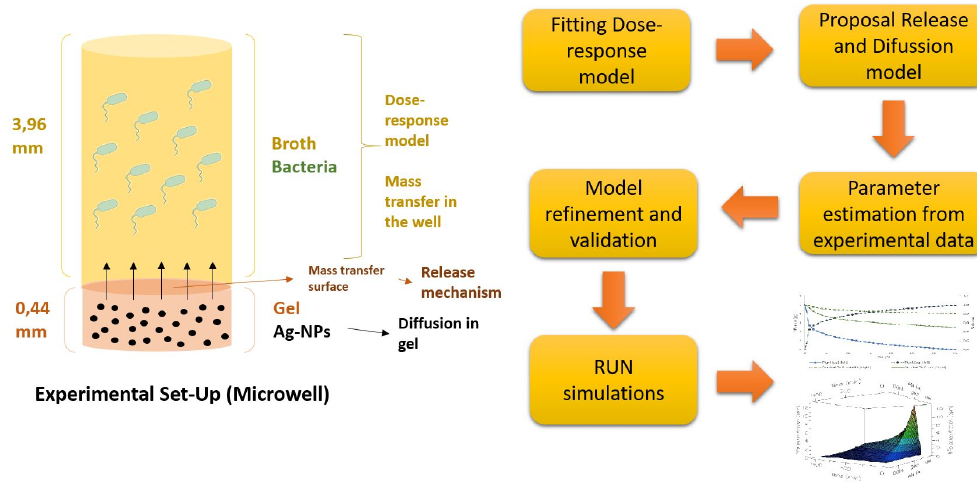
Figure 9. Experimental set-up and steps of modelling.